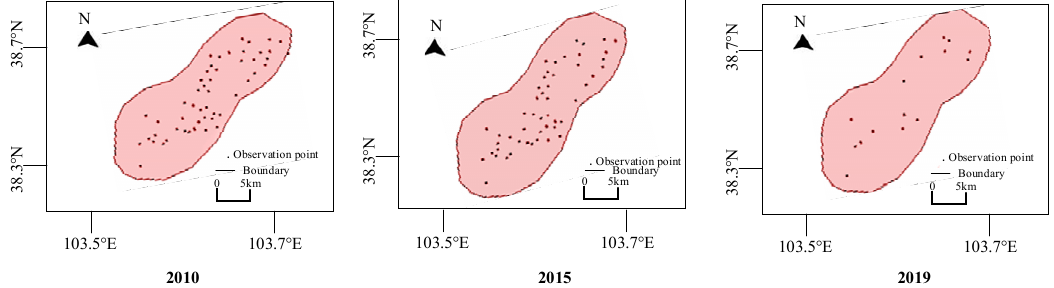
Figure 2. The distribution of spatial interpolation sites in the selected research area under different representative years. representative